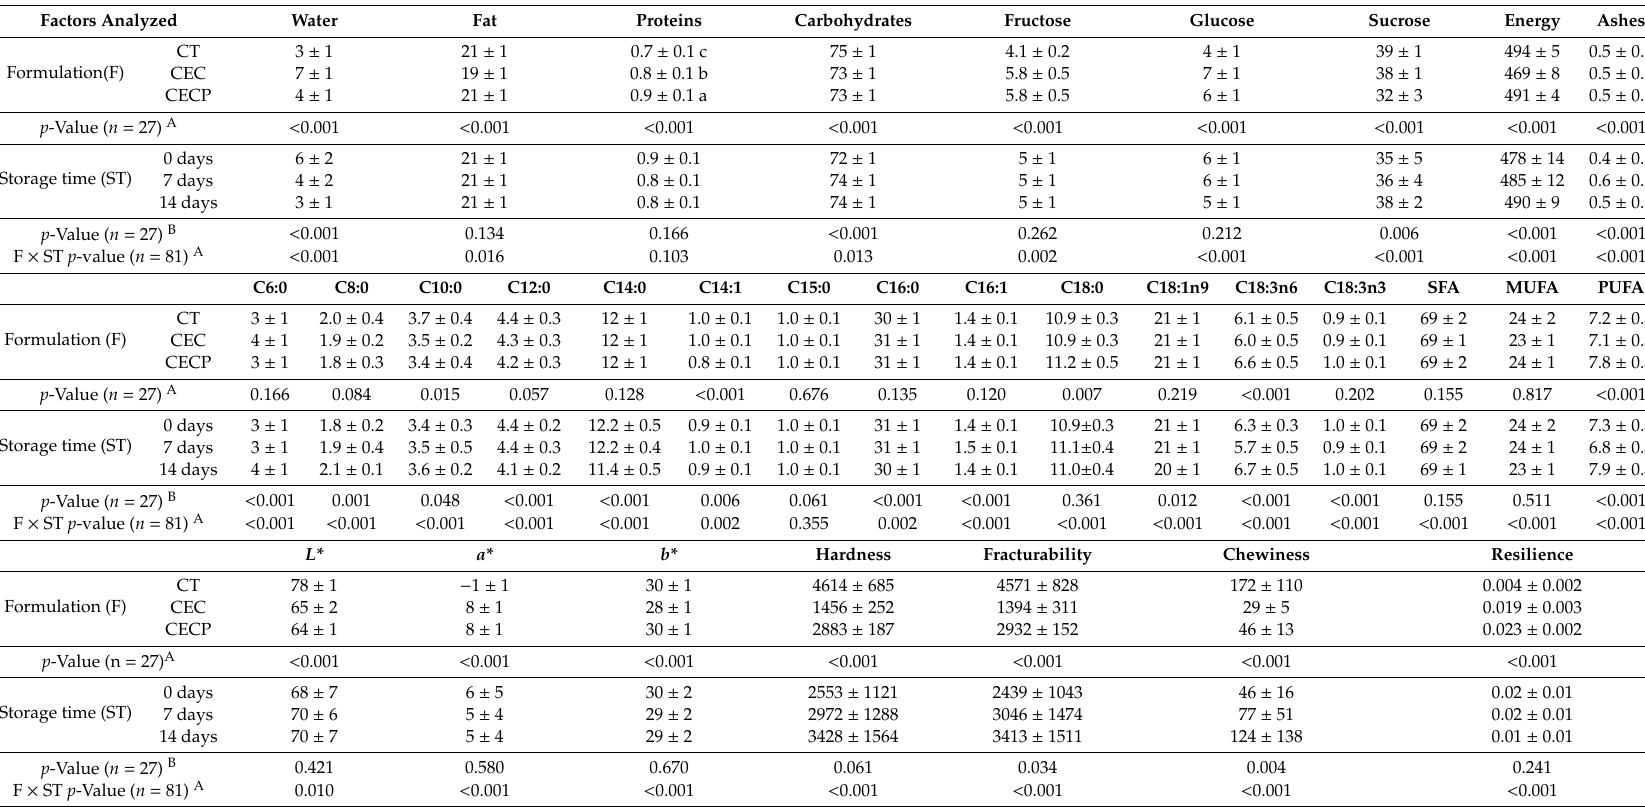
Table 5. Nutritional composition, free sugars (g / 100 g), energy value (kcal / 100 g), profile in fatty acids, colorimetric parameters and textural characteristics of the di ff erent formulations of casadinhos